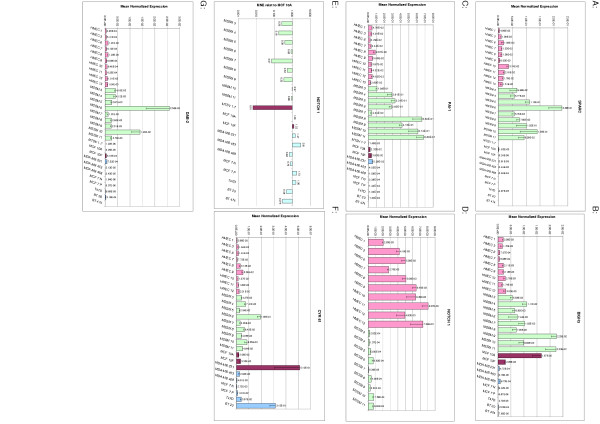
Relative expression of some genes validated byQ-PCR. a) Mean normalized expression (MNE) of SPARC. b) MNE of BIGH3 = TGBFI. c) MNE of PAI-1. d) MNE of NOTCH1 in HMECs and MSSMs cells. e) Relative expression, of MSSMs and established cell lines, toMCF10A. Note the difference between the two MCF7s. f) MNE of CYR61. g) MNE of DAB-2. For the complete list of validated genes, see Table S1.